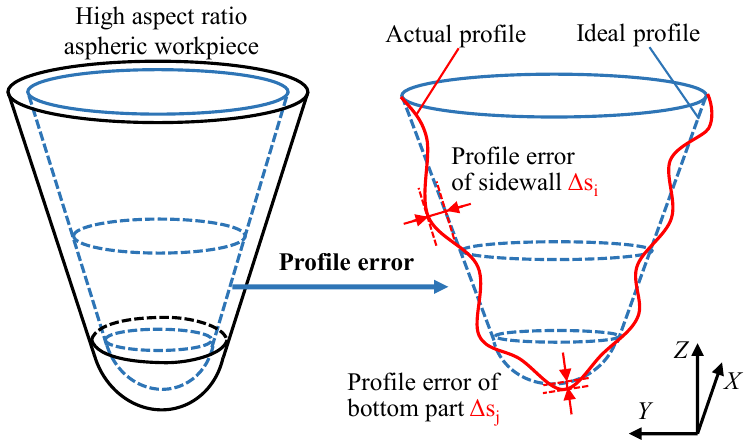
Figure 2. Schematic of error of inner profile of the high aspect ratio aspheric workpiece.